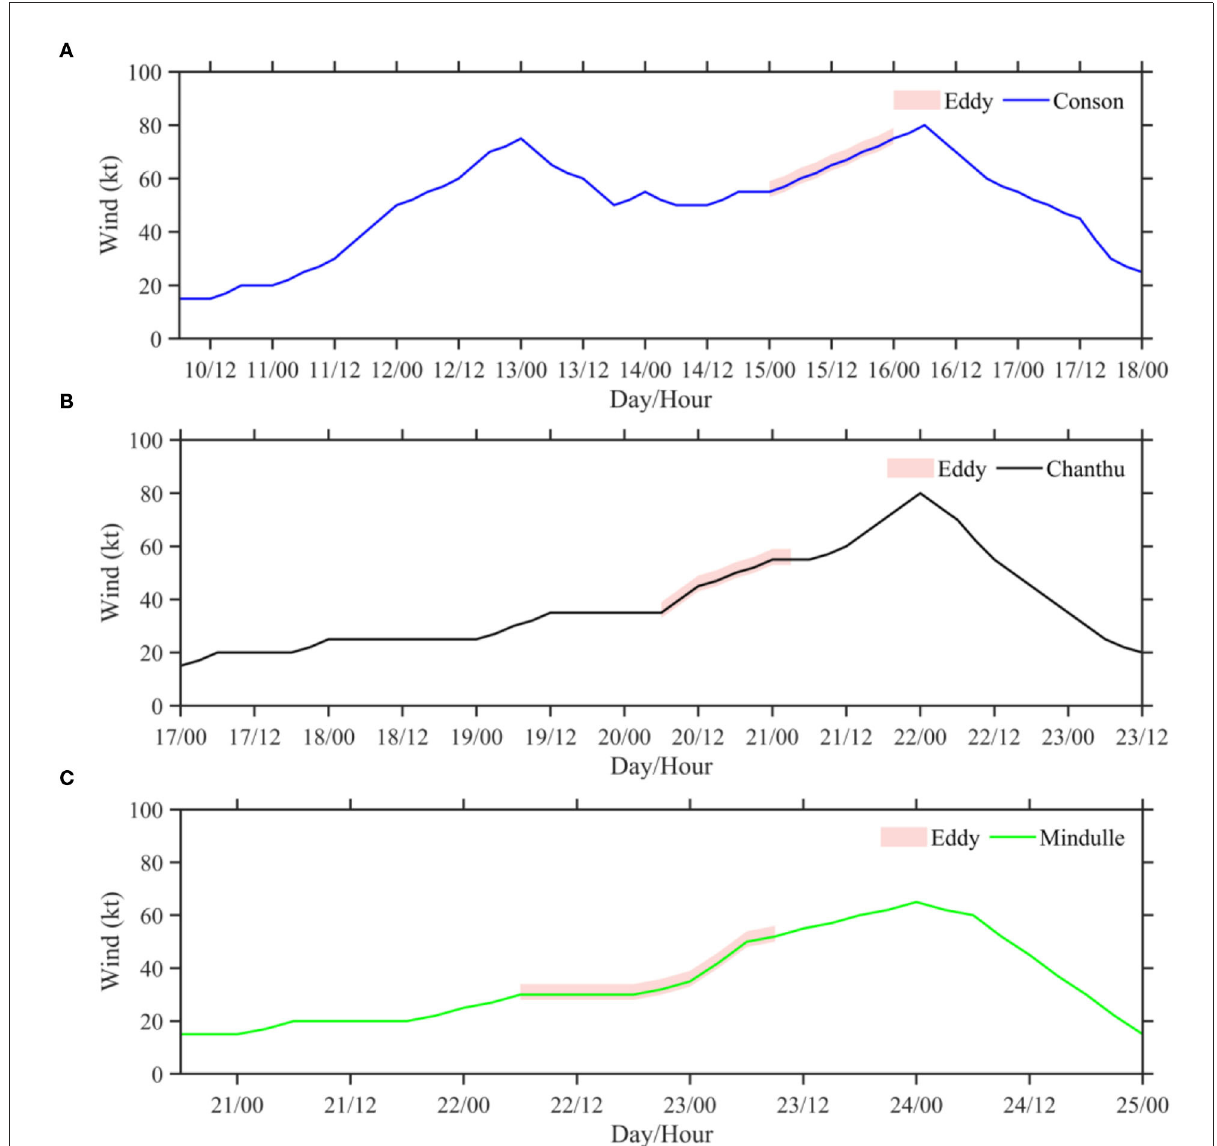
FIGURE2 The evolution of sustained maximum wind speed of (A) TC1/Conson, (B) TC2/Chanthu, and (C) TC3/Mindulle. The pink shading represents the maximum wind speed of TCs when they passed over the warm eddy.